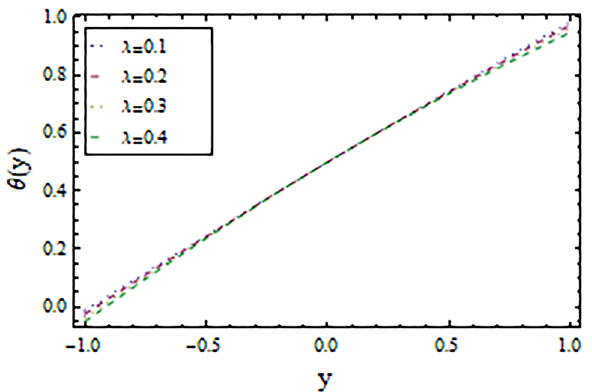
Figure 9. Temperature distribution for A = 0.002, B = 0.01and M = 0.002 using NIM.